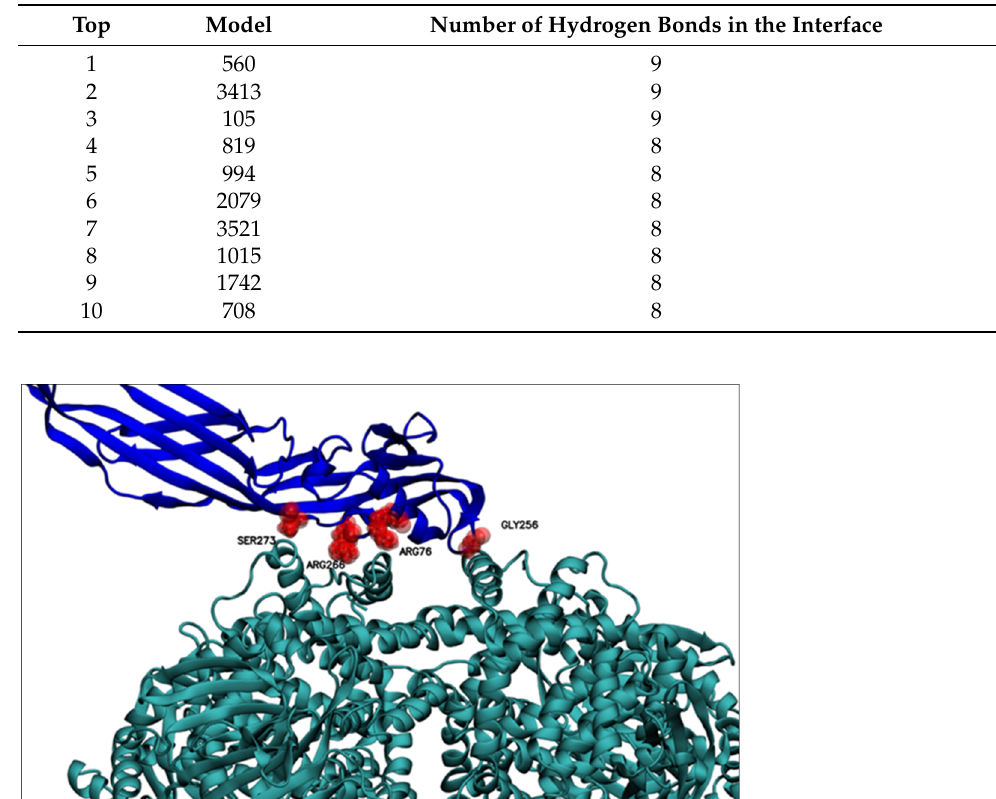
Table 3. Top 10 models according to the number of hydrogen bonds in the interface.